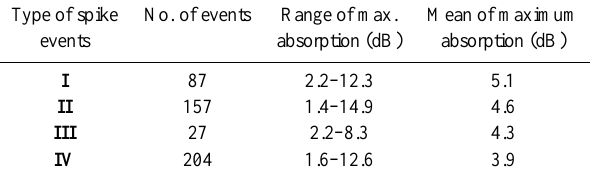
Table 1. Number of events and the range and mean of maximum absorption in each type of